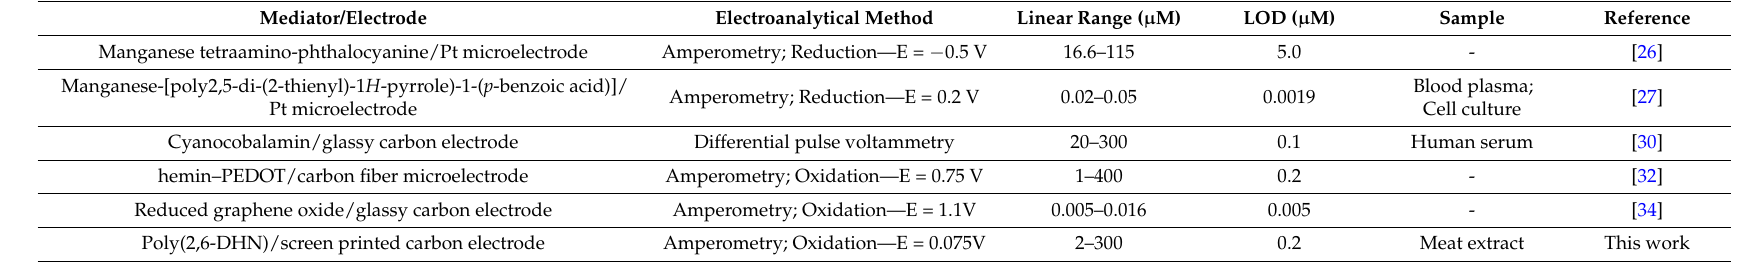
Table 1. Comparison between the analytical features of different PON